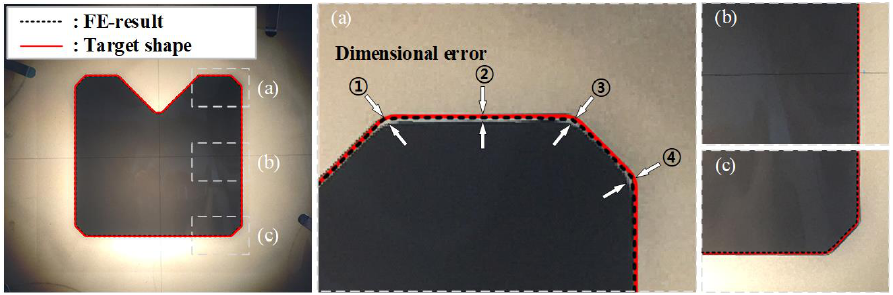
Figure 16. Comparison of the cross-sectional shape for the cross-roller guide: ( a ) Top; ( b ) Middle; ( c ) Bottom.